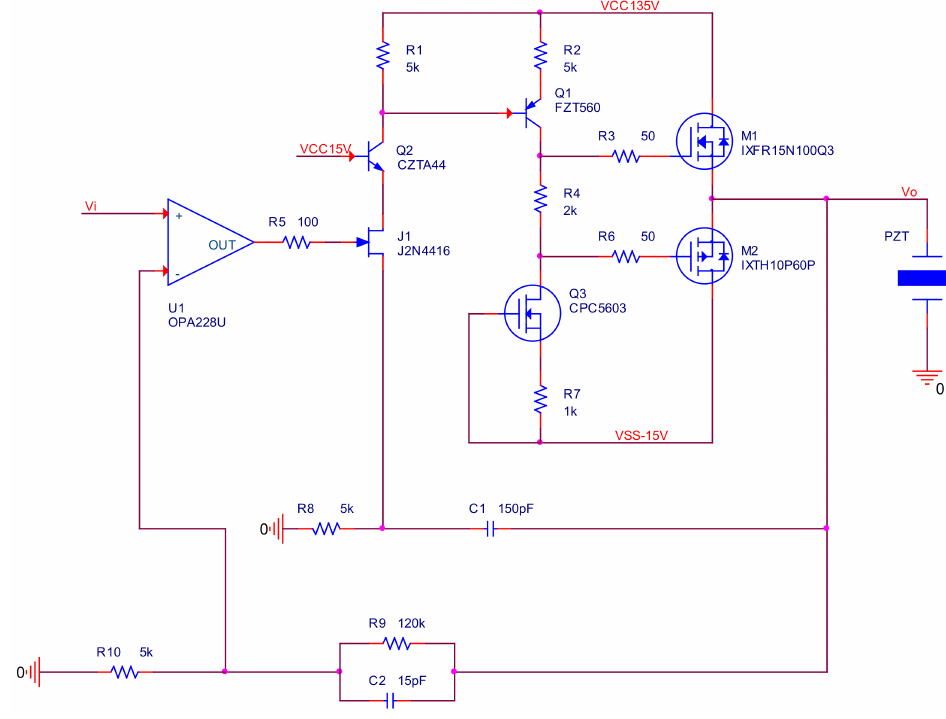
Figure 19. The schematic of the power amplifier using general operational amplifiers.